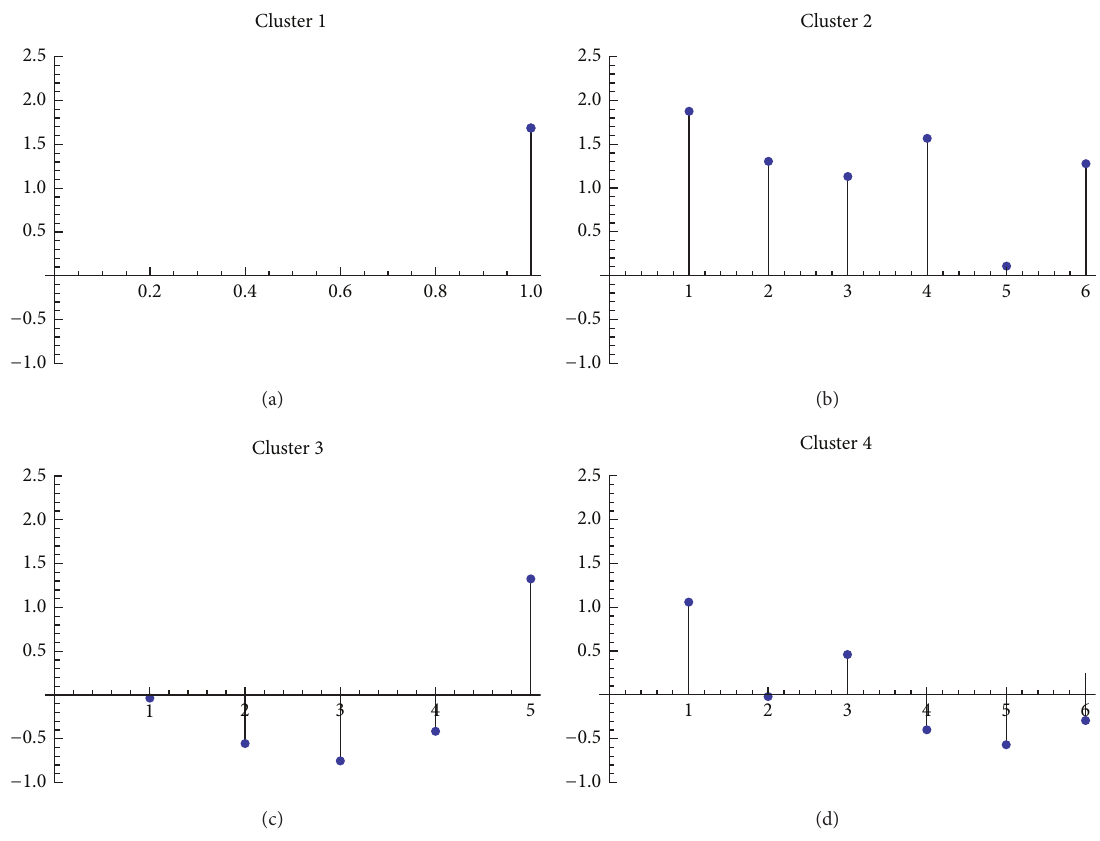
Figure 2: Representation of the estimation of the autonomous model parameters, 𝛼 𝑖 , per cluster. Notice that countries in cluster 2 have similar values for autonomous decision except for Uruguay (identified by number 5 in cluster 2) whose gross public sector debt contracted in the second quarter of 2010, after five consecutive periods of sustained increase, and reached the equivalent to 59.5% of the GDP [30]. Analogously, in cluster 3 except for Trinidad and Tobago (identified by number 5), which is considered one of the wealthiest and most developed nations in the Caribbean [31]. The countries are in the same order as they appear in Table